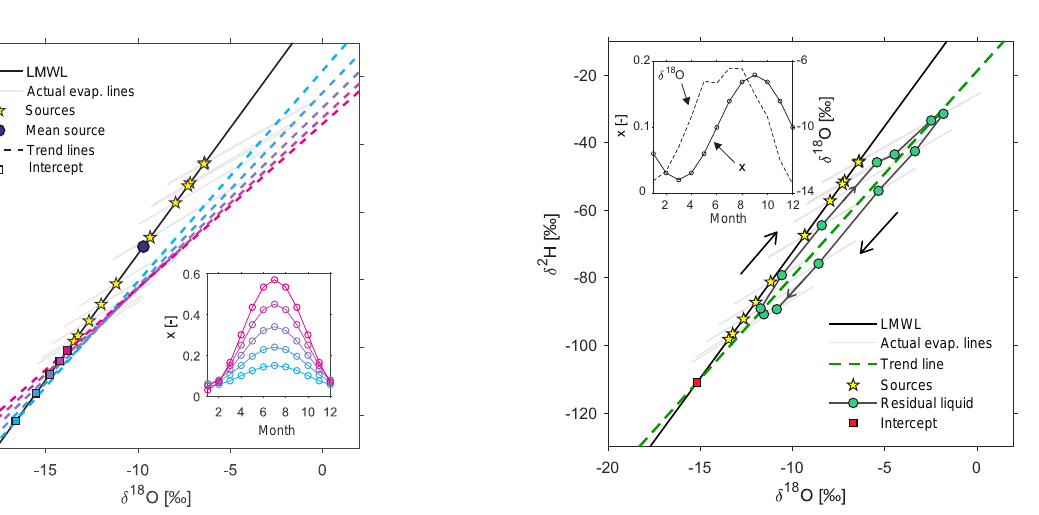
Figure 5. Examples of trend lines and intercepts arising from vari- ous seasonal evaporation patterns (inset).